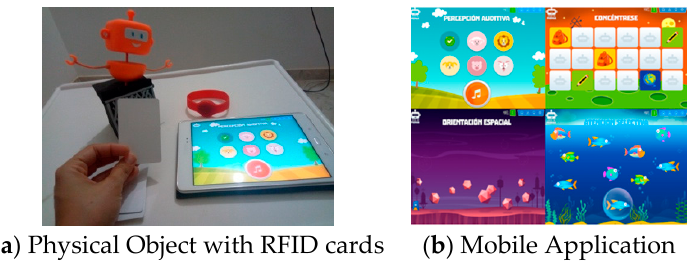
Figure 1. Tangible interface Stimulating with PhonaTIC for children with a cochlear implant.